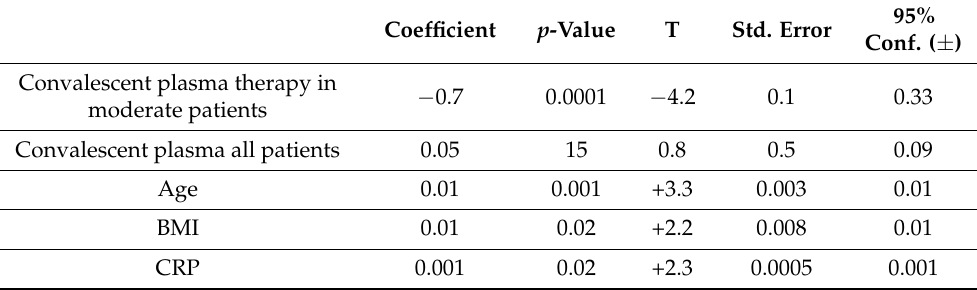
Table 2. Correlations between risk factors and mortality in COVID-19 patients. Univariate analysis of the strength of risk factors with mortality prediction. Convalescent plasma prevents mortality in moderate patients. Abbreviation: BMI body mass index: SE are the standard errors of the regression coefficients. T is the quotient of the coefficient. Two-sided p values or observed significance levels.